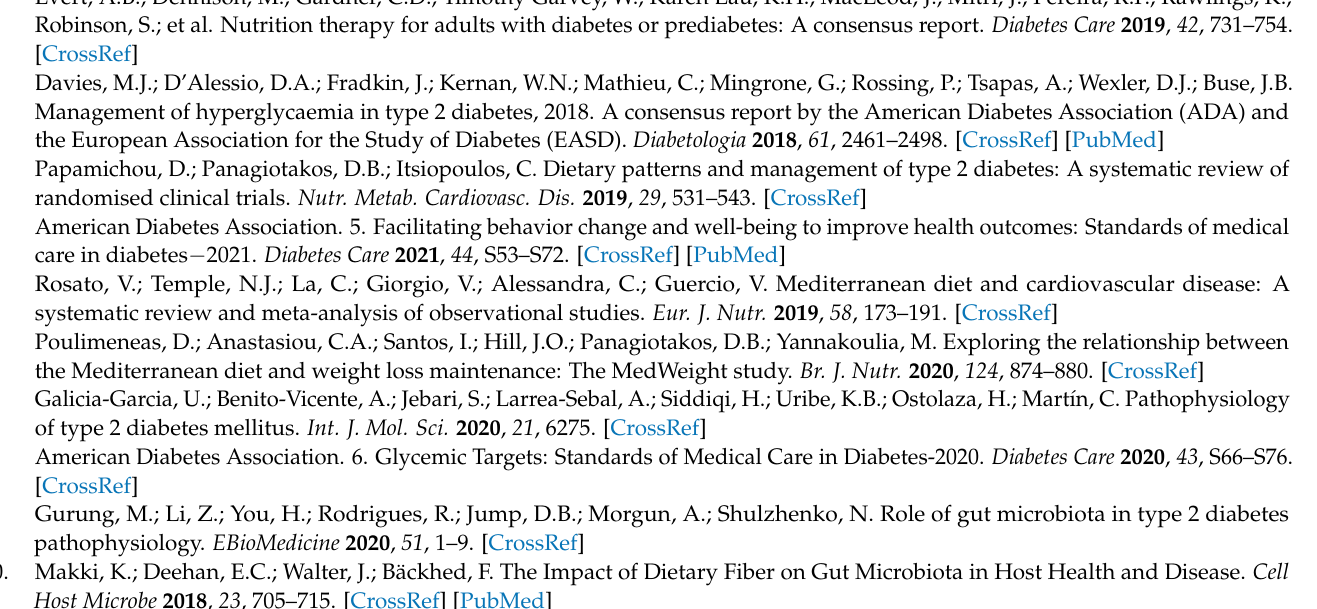
trients ingested quantity. Table S2: Biochemical parameters. Figure S1: Clustering of bacterial genera (A) and species (B) according to Mediterranean diet adherence visualized as a